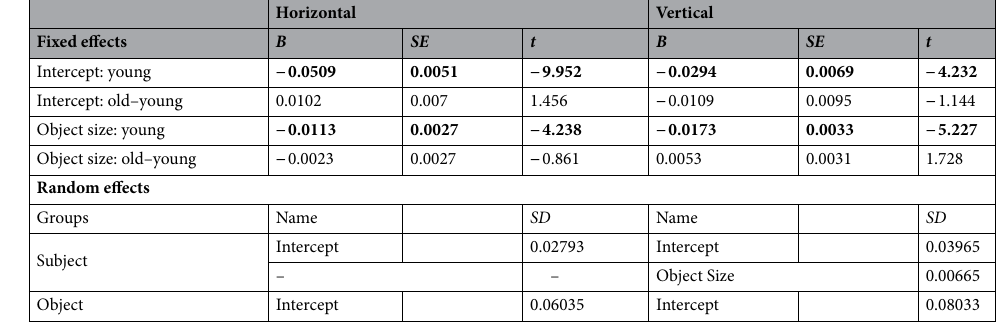
Table 4. Preferred viewing location for objects in scenes. Significant coefficients are set in bold (| t |> 1.96). Results from two separate linear mixed models, fitting horizontal and vertical landing positions for initial fixations on objects. Standardized coefficients ( b ), standard errors ( SE ), and t -values for fixed effects and standard deviations ( SD ) for random effects are provided.